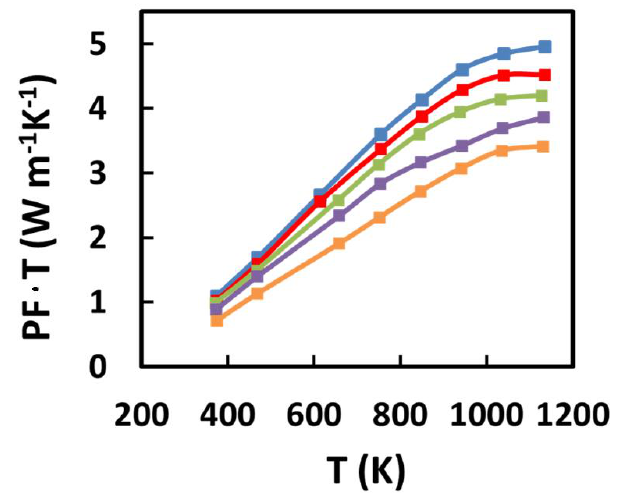
Figure 4. PF · T product as a function of temperature for n-type Hf 0.6 Zr 0.4 NiSn 0.995 Sb 0.005 HH compounds produced by SPS at 1350 (blue), 1250 (red), and 1100 °C (green); as cast ingots annealed at 1000 °C for two days (purple), and 700 °C for eight days (orange). (Extracted from Reference [11]).